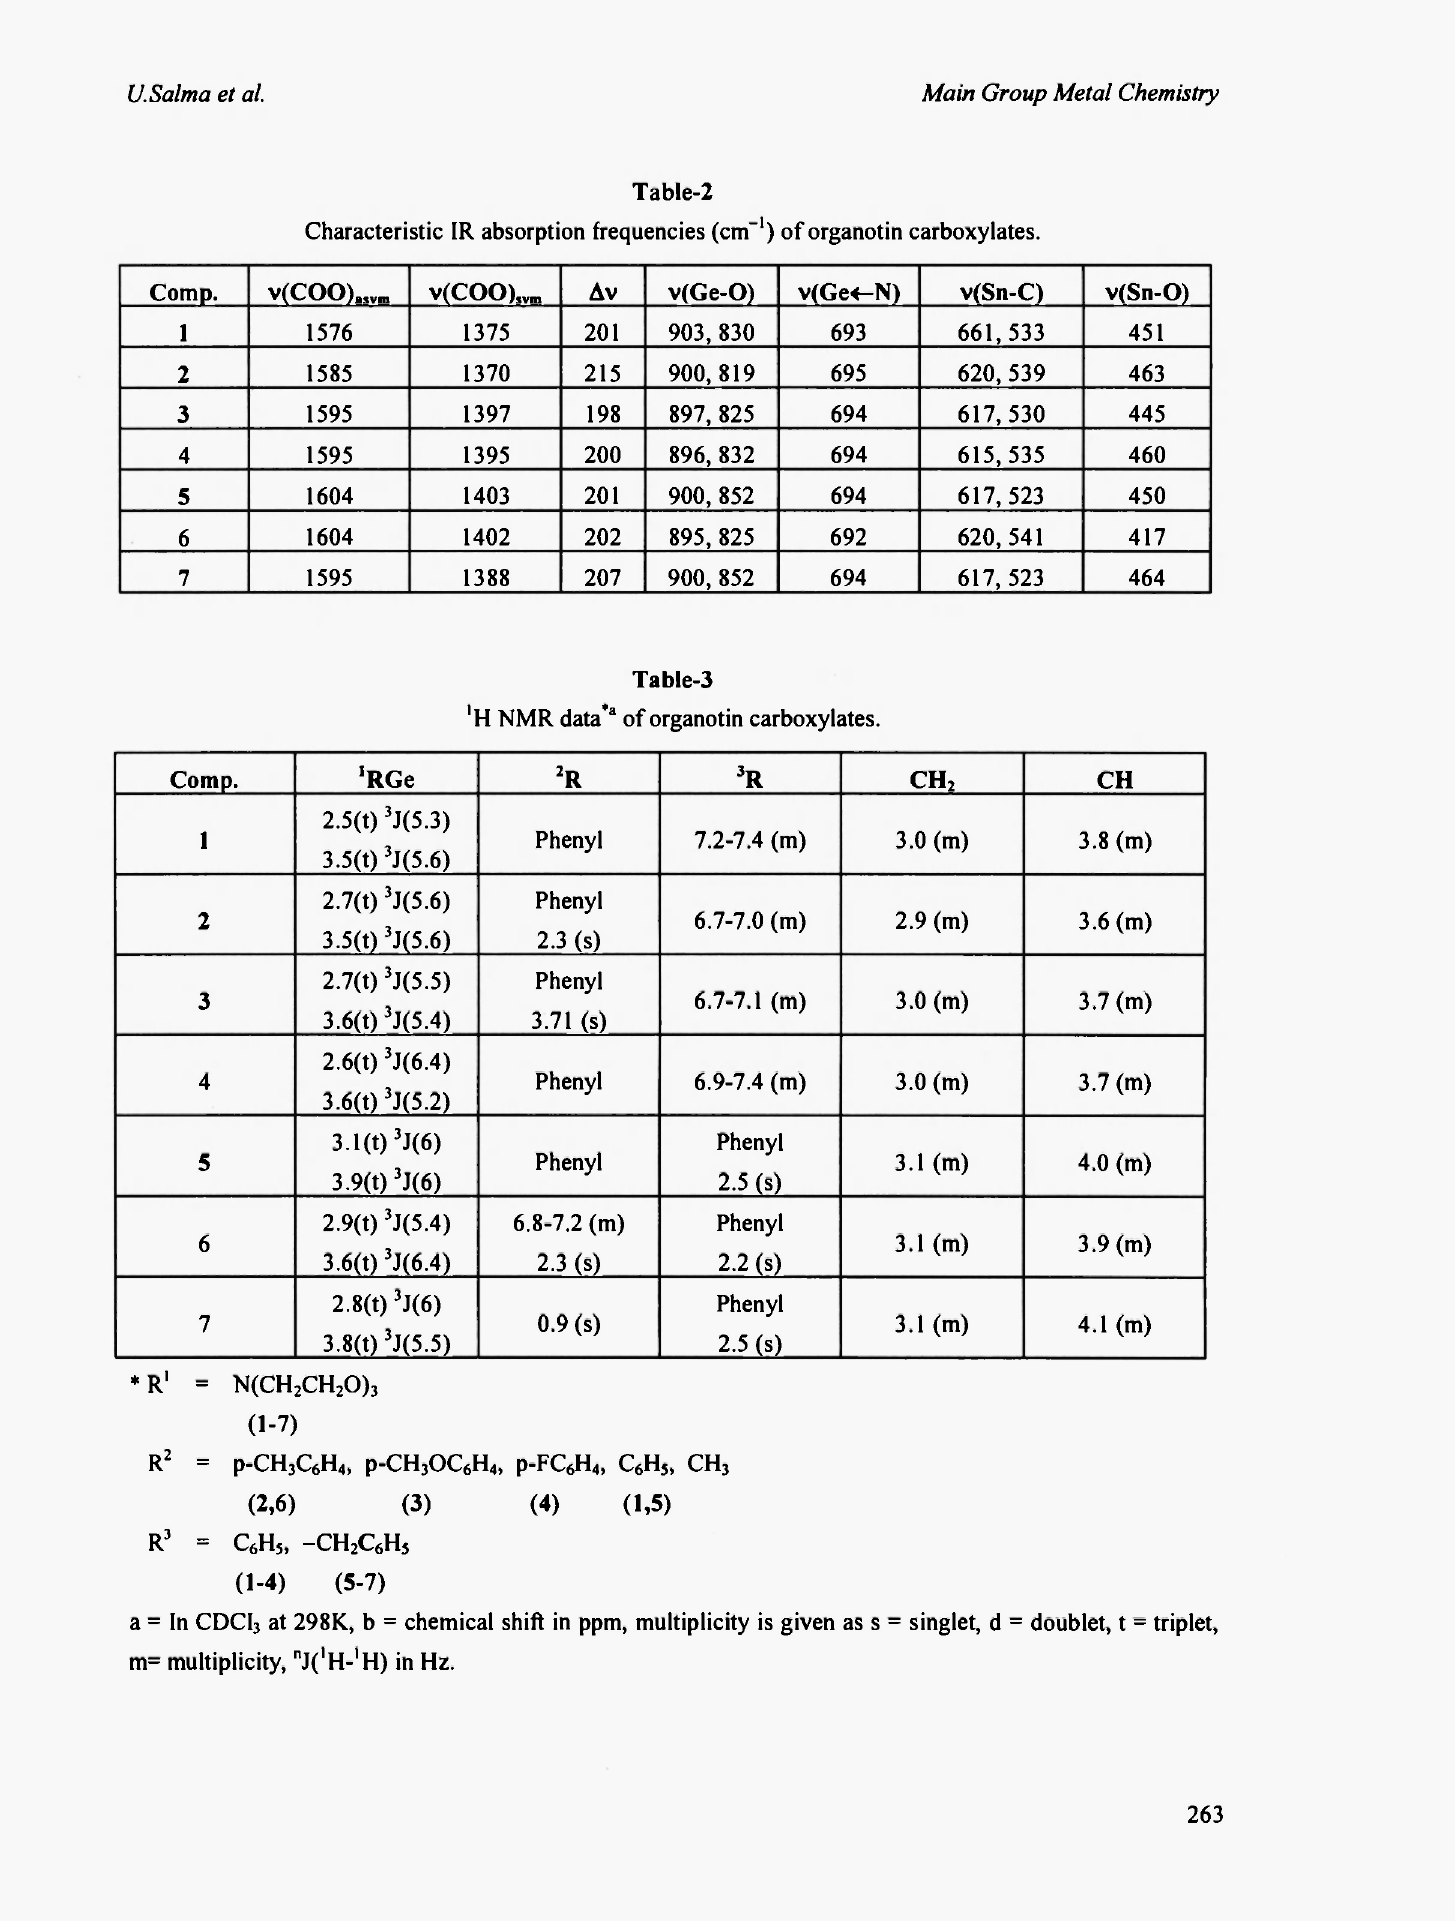
'H NMR data* 3 of organotin